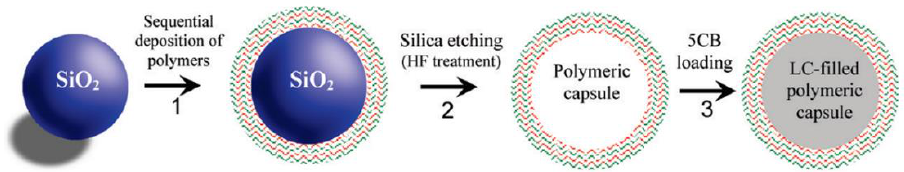
Figure 1. Schematic illustration of the procedure used to prepare LC droplets of predetermined sizes within polymeric multilayer shells. Reprinted with permission from ref. [55] Copyright 2009 American Chemical Society.